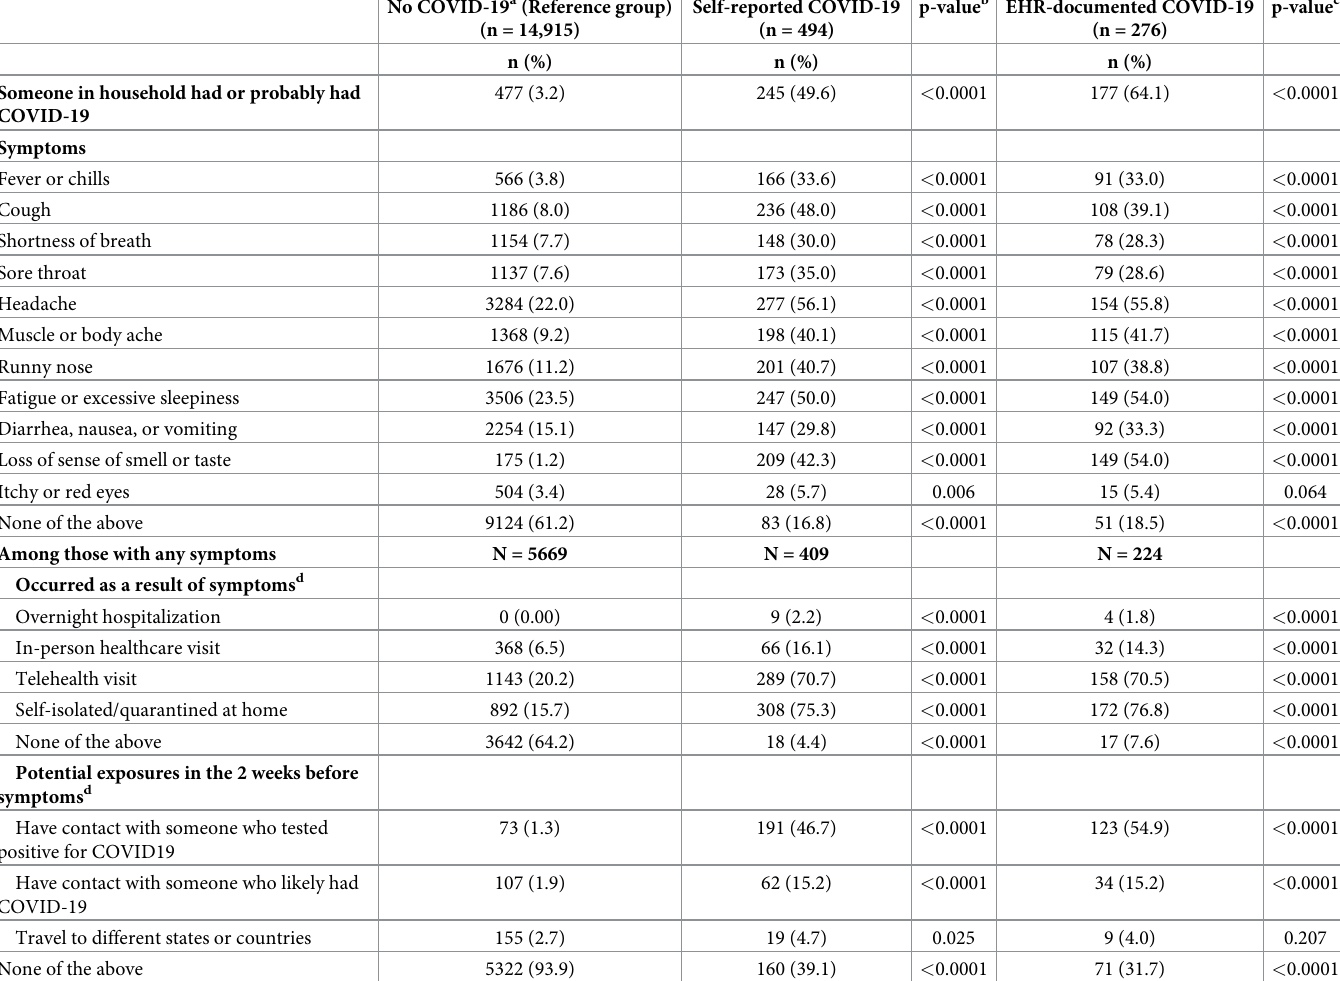
Table 4. Self-reported symptoms during pregnancy, consequent healthcare use, and possible sources of COVID-19 exposures in the two weeks before symptoms started. No COVID-19 a (Reference group) (n =